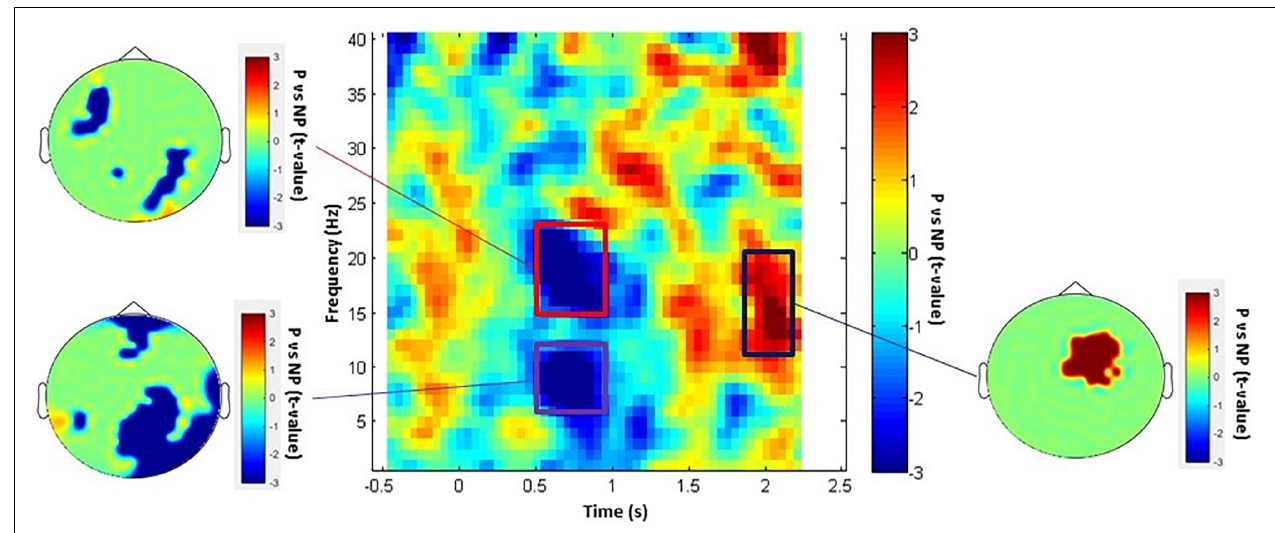
FIGURE 1 | P vs NP TFR and topographical maps. The TFRs include time window of –0.5 to 2.5 s (averaged over all channels) and topography of each statistically significant time-frequency window. The rectangular insets represent time-frequency windows of activity that were statistically significant (P cluster − cor <